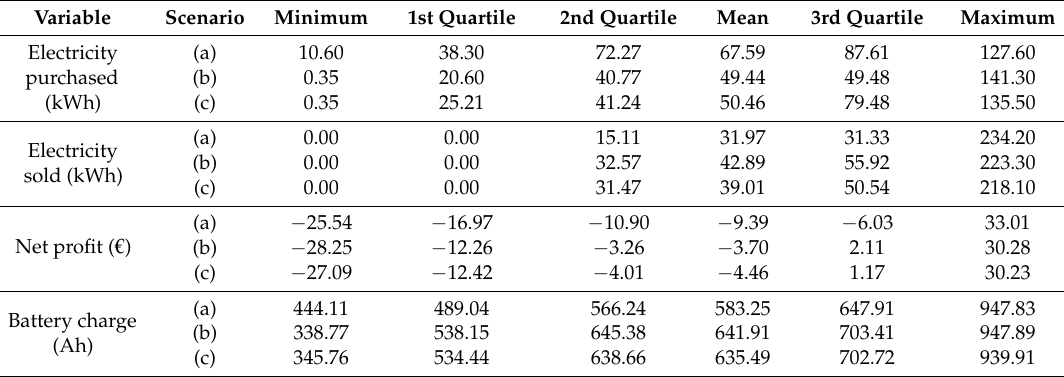
Table 3. Case study 1: Summary of descriptive